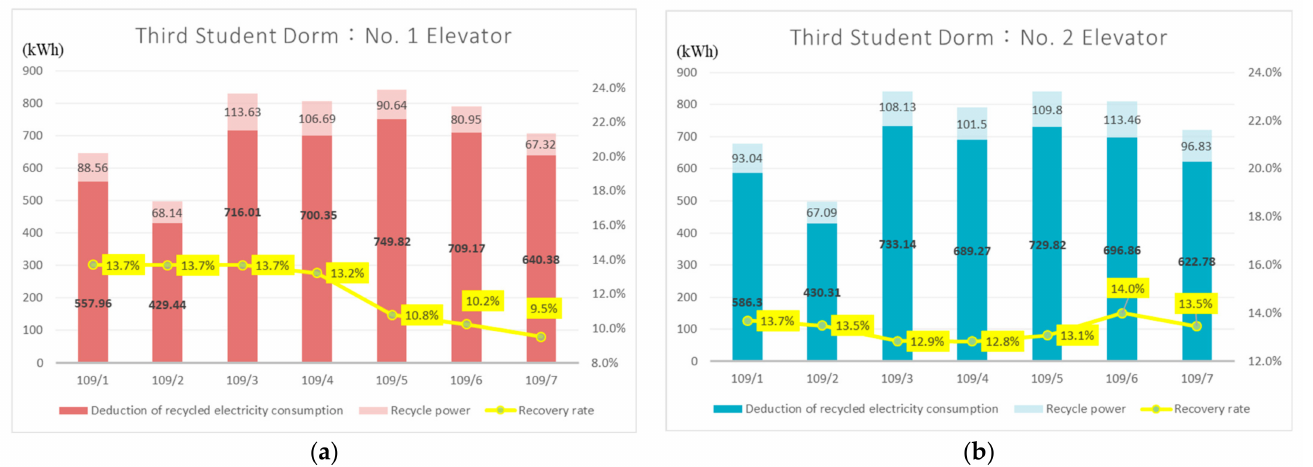
Figure 15. Electricity consumption and recycle power of elevator in second student dorm: ( a ) no. 1 elevator; ( b ) no. 2 elevator.